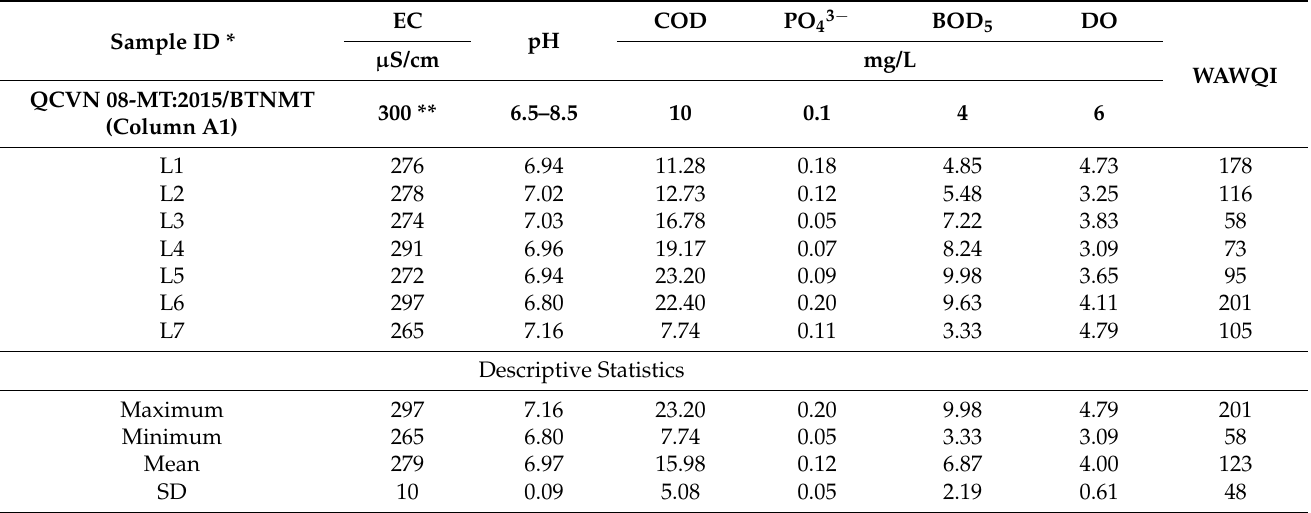
Table 4. Calculation of the WAWQI for the LNHNR in the 2016 Wet Season.